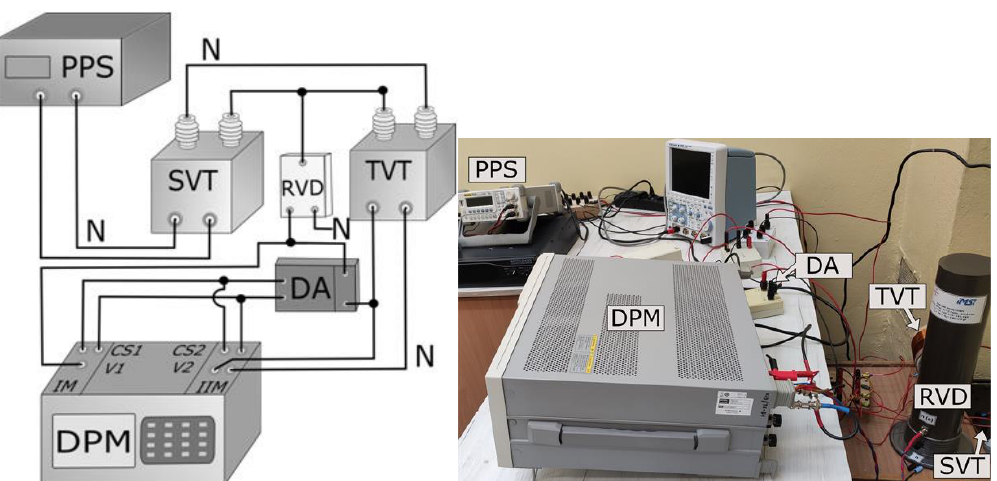
Figure 4. Diagram and picture of a measuring system for checking the accuracy of harmonic transformation of voltages distorted by voltage transformers: where: PPS—programmable power supply system, SVT—step-up voltage transformer, TVT—tested voltage transformer, RVD—reference voltage divider, DA—differential high impedance wideband converter, and DPM—digital power meter.